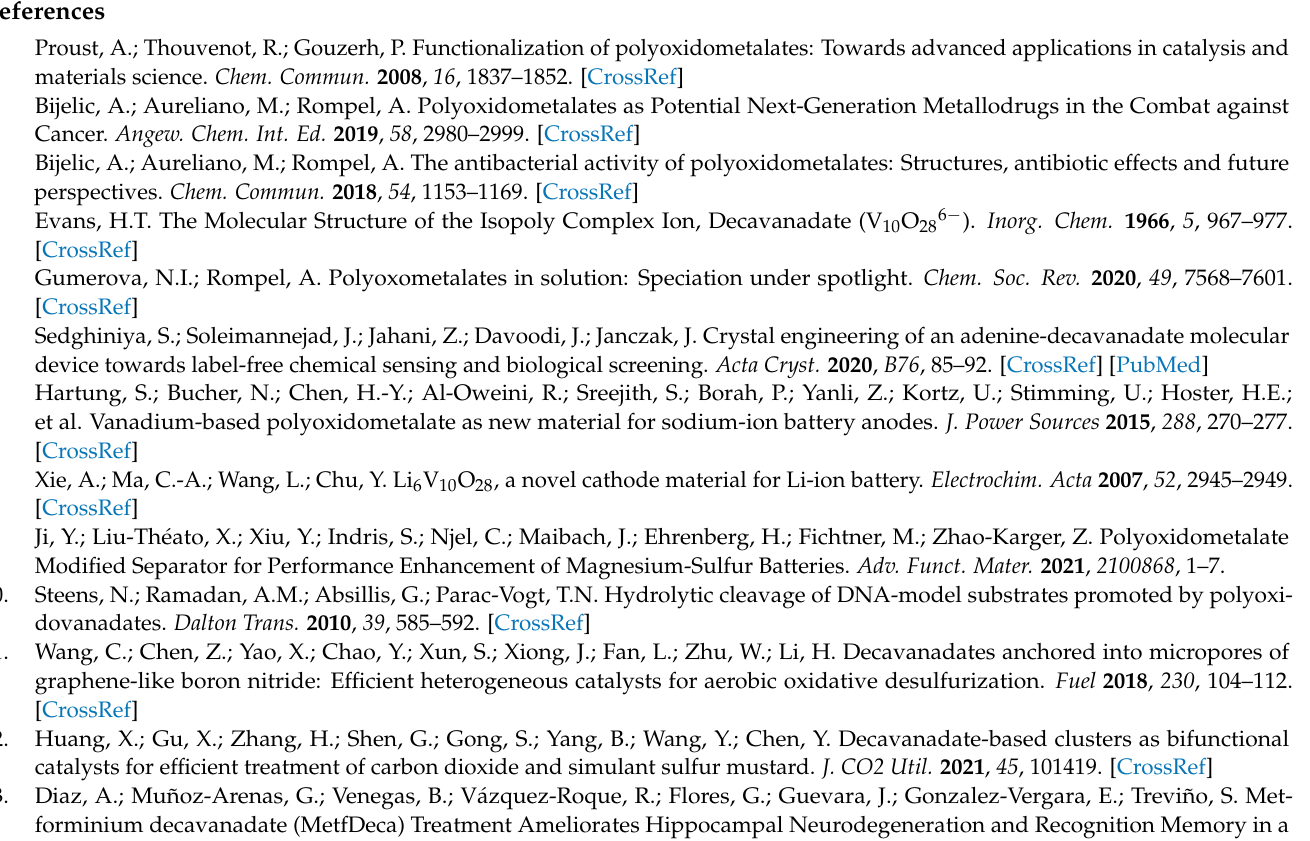
10.3390/inorganics9090067/s1, Table S1: Fractional Atomic Coordinates ( × 10 4 ) and Equivalent Isotropic Displacement Parameters (Å 2 × 10 3 ) for Compound 1 . U eq is defined as 1/3 of the trace of the orthogonalized U IJ tensor, Table S2: Anisotropic Displacement Parameters (Å 2 × 10 3 ) for Compound 1 . The Anisotropic displacement factor exponent takes the form: − 2 π 2 [h 2 a* 2 U 11 + 1 , Table S5: Torsion Angles for Compound 1 , Table S6: Hydrogen Atom Coordinates (Å × 10 4 ) and Isotropic Displacement Parameters (Å 2 × 10 3 ) for Compound 1 , Table S7: Atomic Occupancy for Compound 1 , Figure S1: TG spectrum of Compound 1 in the range of 35–950 ◦